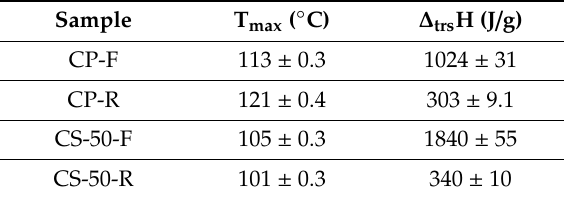
Table 2. T max values and the change in transition enthalpy ( ∆ trs H) from DSC for the single components and the composite